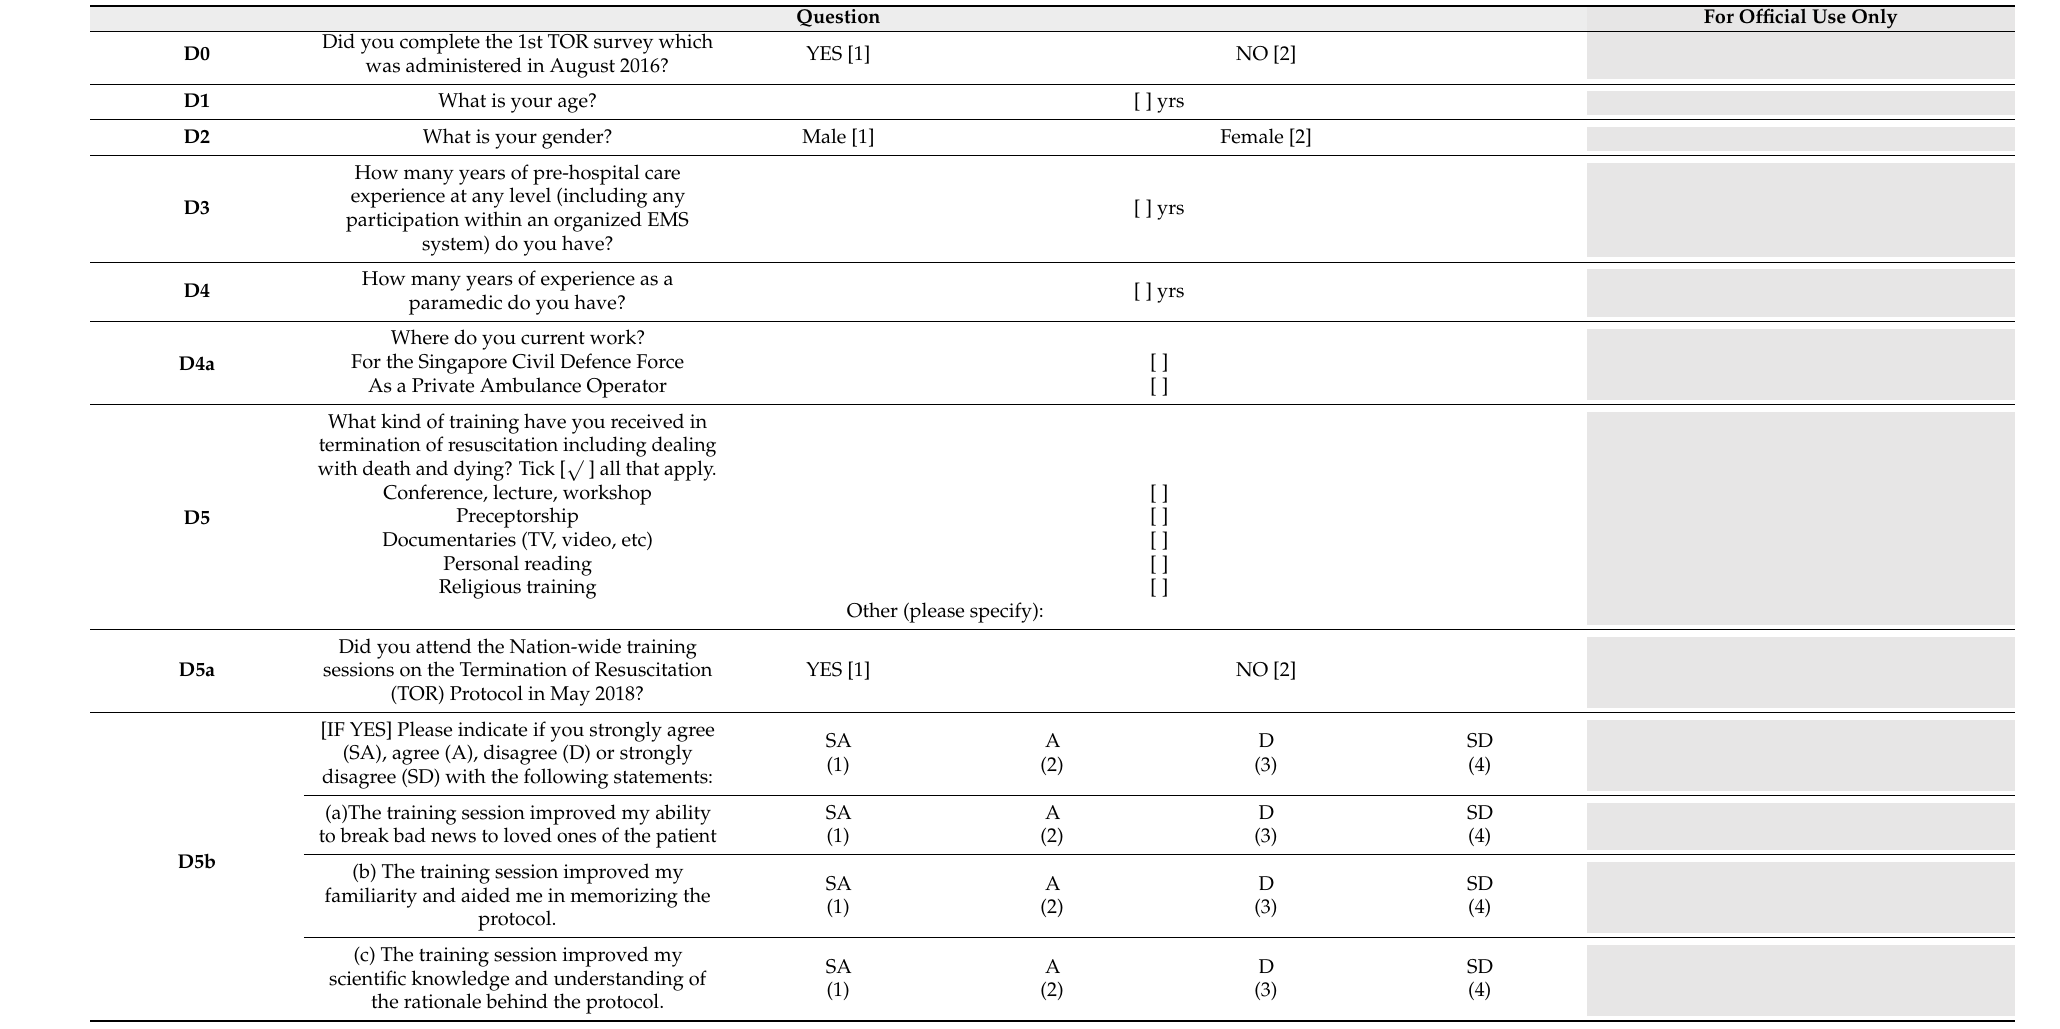
Table A2. Paramedic Survey on Termination of